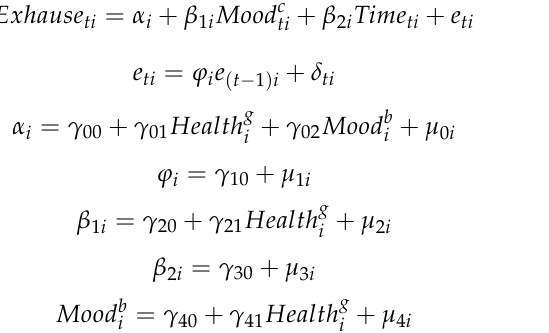
Table 1. Means, standard deviations, and correlations between the study variables.